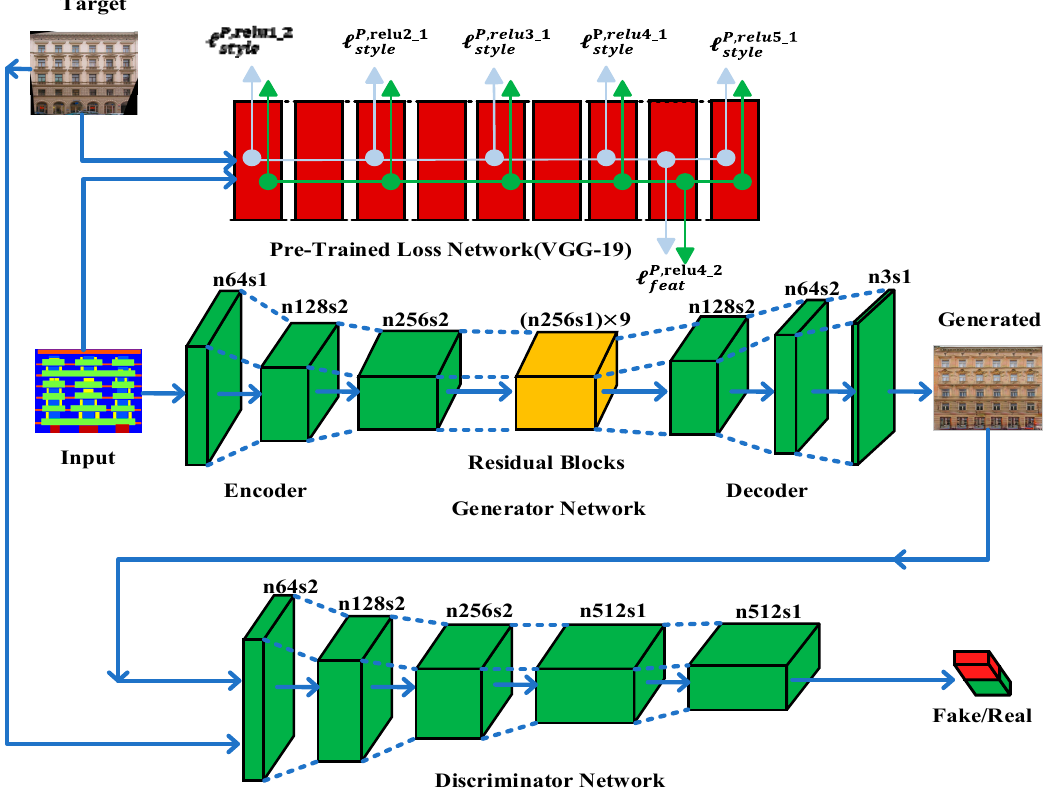
Figure 2. IP-RAN framework. IP-RAN consists of generator network, G , input-perceptual loss network, P , and discriminator network, D . The generator network, G , is intended to generate translated images from given input images. It is composed of an encoder-decoder structure that includes two down-sampling layers of stride-2 convolution, several residual blocks, and two up-sampling layers stride-2 of transposed convolution. Input-perceptual loss network, P , is the pre-trained VGG-19 and used to extract features from hidden layers to calculate the perceptual loss. The discriminator network, D , consists of convolutional-BatchNorm-LeakyRelu layers, and its output is used to distinguish generated images from real images.